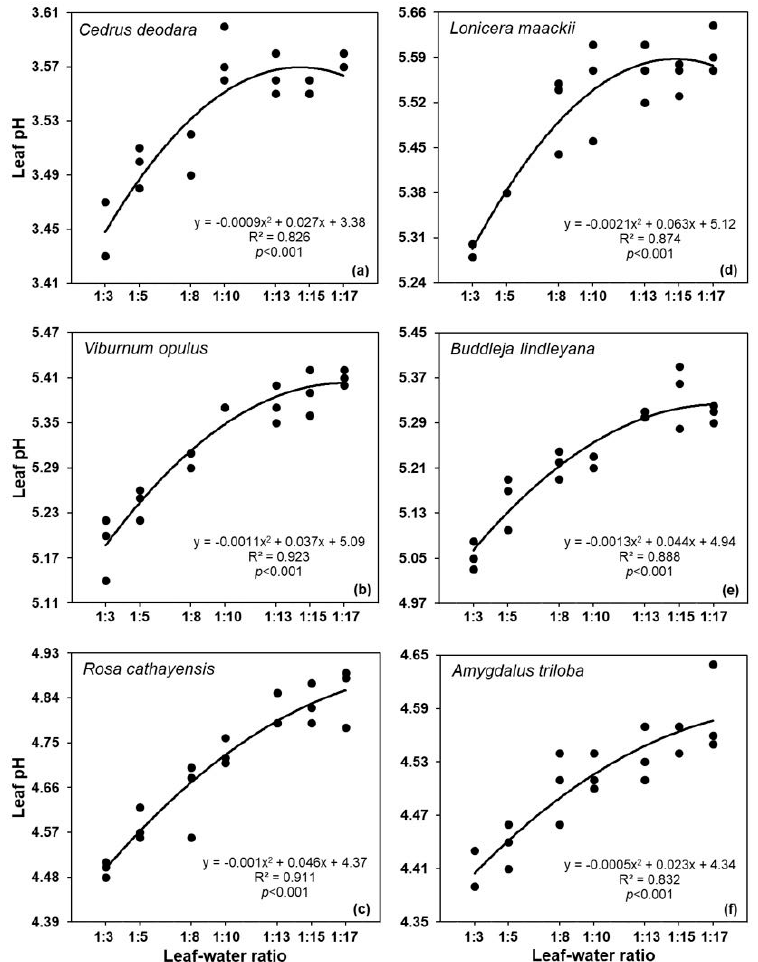
Figure 3. Relationship between leaf–water ratio and leaf pH. Dried leaf samples of ( a ) Cedrus deodara , ( b ) Viburnum opulus , ( c ) Rosa cathayensis , ( d ) Lonicera maackii , ( e ) Buddleja lindleyana , and ( f ) Amygdalus triloba were used here. See Materials and Methods for details.